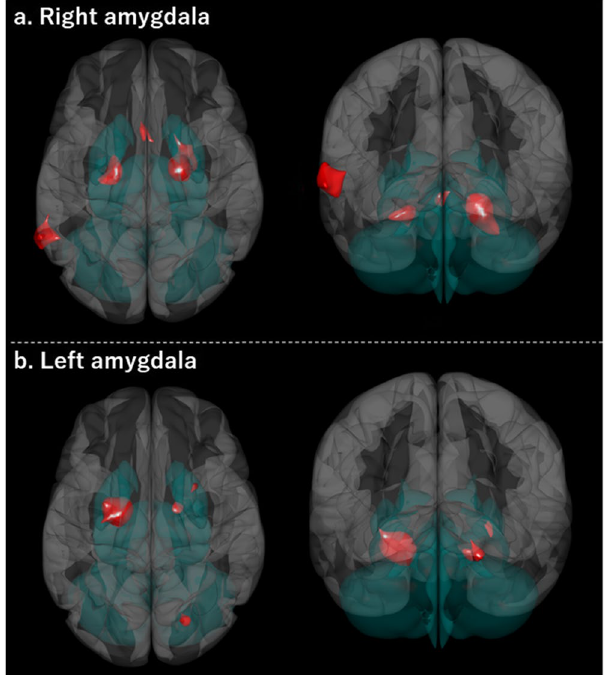
Figure 1. Amygdala-centred functional connectivity during fearful faces processing. Seed region: the amygdala that showed significantly increased activation in response to fearful faces (vs. neutral faces) in this sample (L-Amy: MNI − 21 − 10 − 17, 351 mm 3 , R-Amy: MNI 21 − 10 − 17, 189 mm 3 ), which are comprised of the caudomedial portion of the amygdala. Clusters were significant at FDR-corrected p < 0.05 [both height threshold and cluster threshold (cluster-size correction)]. Abbreviations: L-Amy, left amygdala; R-Amy, right amygdala; MNI, Montreal Neurological Institute space; FDR, false-discovery rate.